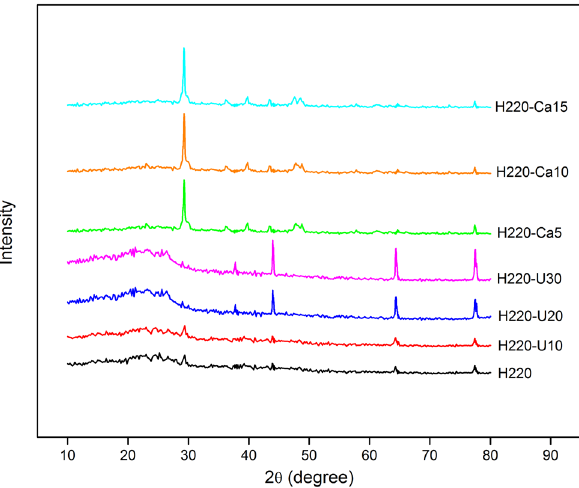
Figure 2: XRD patterns for hydrochar resulting from HTC under dif - ferent conditions.